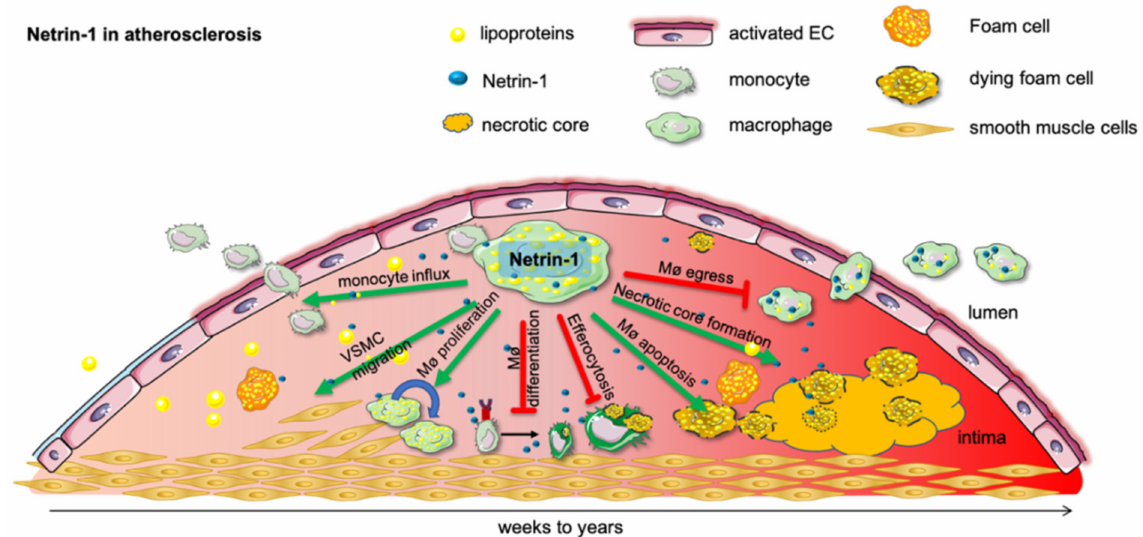
Figure 2. Netrin-1 in atherosclerosis. Subendothelial lipoprotein accumulation incite a proinflamma- tory activation of the endothelial cells and promote monocyte influx into the developing atheroscle- rotic plaque. As lipoproteins undergo various modifications, such as oxidation and hydrolysis, they are taken up by monocytes and form proinflammatory foam cells. In this inflammatory milieu chronically, activated macrophages secrete netrin-1, which recruit further monocytes and retain macrophages in the tissue until they undergo apoptosis and form the detrimental necrotic core. Netrin-1 further mitigates pro-resolving macrophage differentiation and efferocytosis. Moreover, netrin-1-secreting macrophages advance the plaque further by recruiting smooth muscle cells into the developing plaque, which can themselves become macrophages and promote the ongoing progression of the